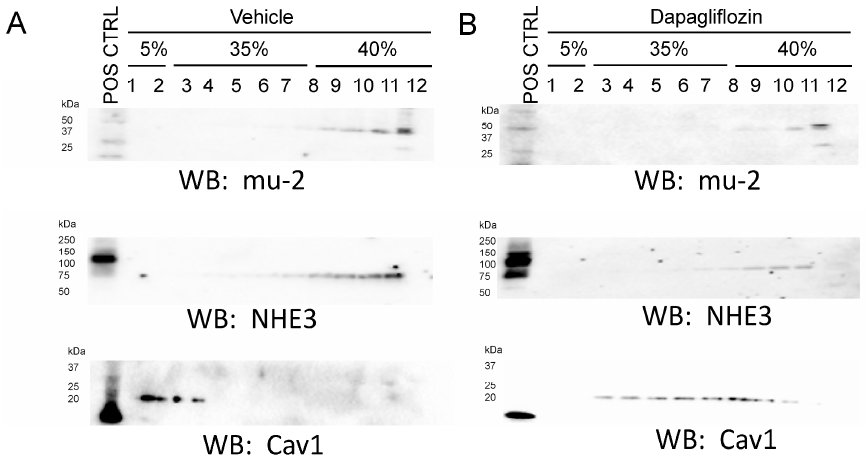
Figure 5. Sucrose density gradient assays from mouse proximal tubule cells treated with dapagliflozin or vehicle. ( A ) Western blot analysis of lipid-raft- and non-lipid-raft-associated fractions from sucrose density gradient fractions of mouse proximal tubule cells treated with vehicle. ( B ) Western blot analysis of lipid-raft- and non-lipid-raft-associated fractions from sucrose density gradient fractions of mouse proximal tubule cells treated with dapagliflozin.